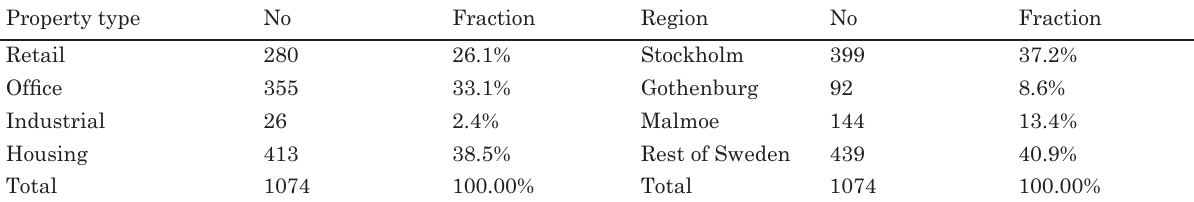
Table 1. databank distribution for 2012